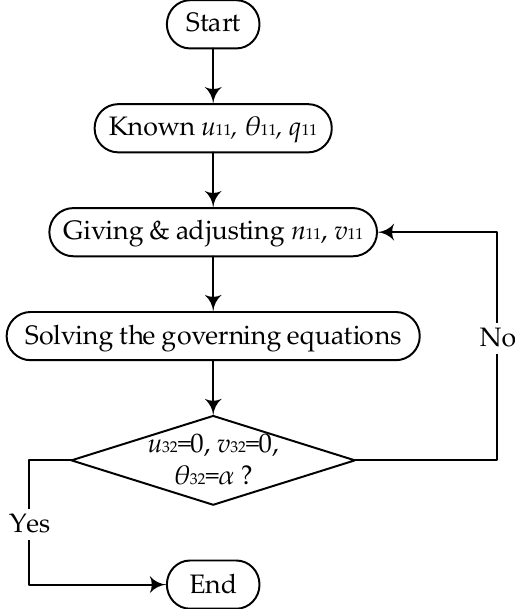
Figure 2. Solution flow chart of the shooting method.